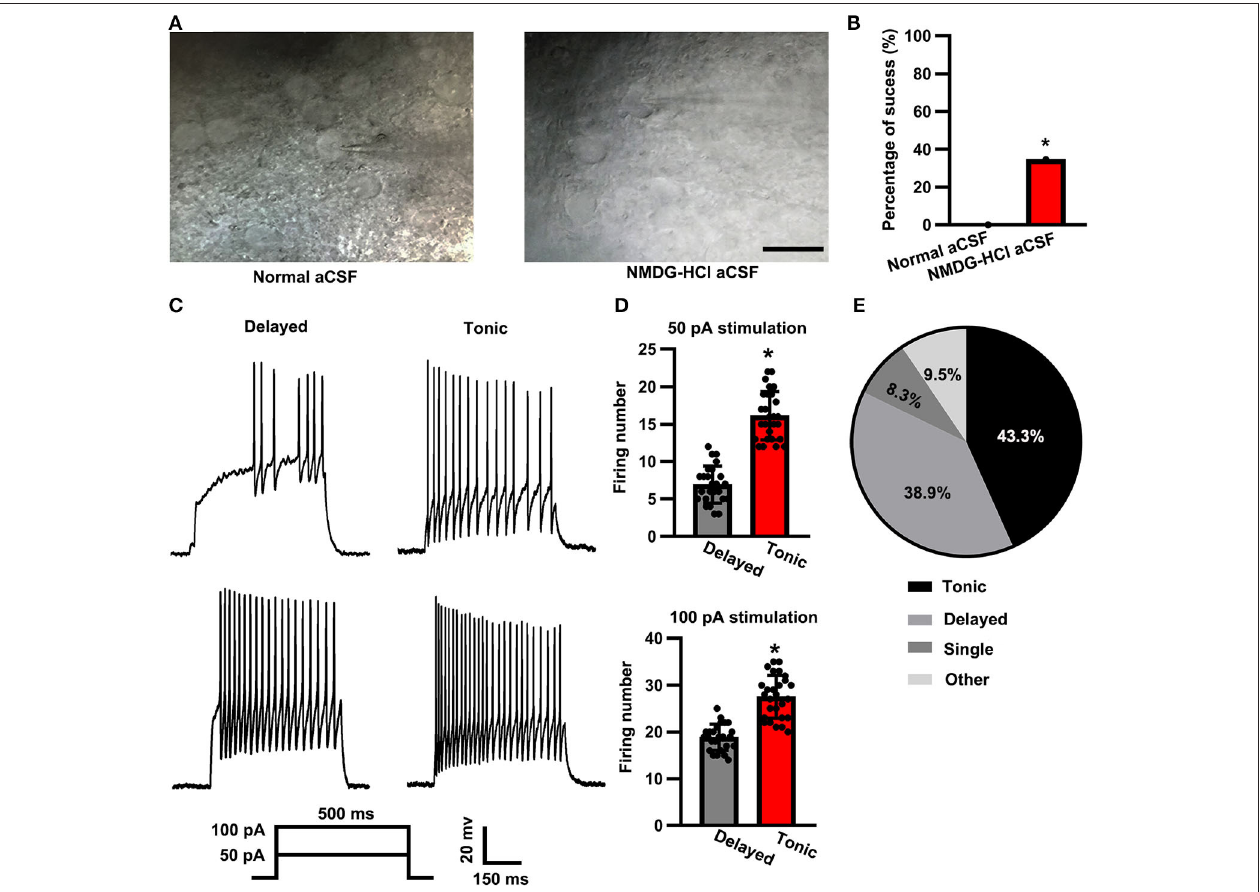
FIGURE 1 | Firing patterns of substantia gelatinosa (SG) neurons. (A) Representative IR- differential interference contrast microscope (DIC) images of the spinal cord slices that were cut with normal artificial cerebral spinal fluid (aCSF) (left panel) vs. N-methyl-D-glucamine HCl (NMDG-HCl) aCSF (right panel). The scale bar was 20 µ m. (B) Statistical analysis of the patch-clamp success rate between the two groups. (C) Representative delayed (left panel) and tonic (right panel) firing patterns at 50 and 100pA of 500ms current stimulation. (D) Statistical firing number of delayed firing pattern and tonic firing pattern neurons at stimulation of 50pA (up panel) and 100pA (down panel). Data were shown as mean ± standard error of the mean (SEM). (E) Distribution of neuron firing patterns (pie chart). * p <